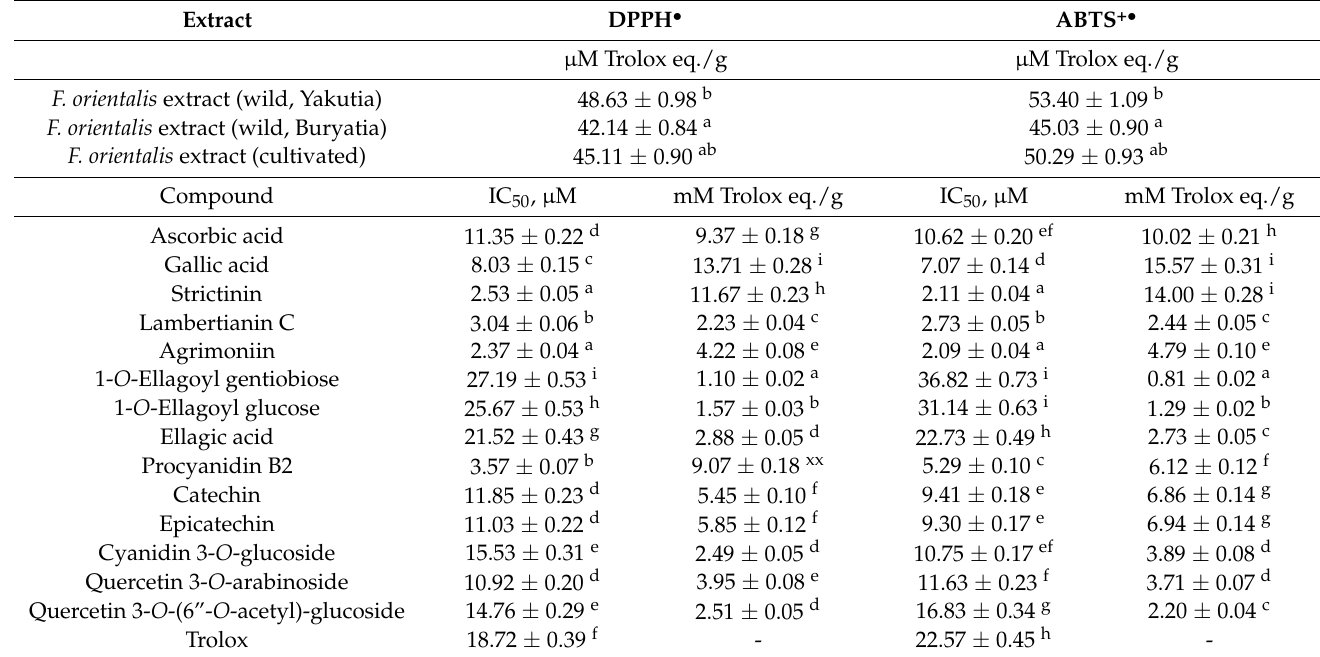
Table 3. Antiradical activity of F. orientalis fruit extracts and selected compounds against 2,2-diphenyl-